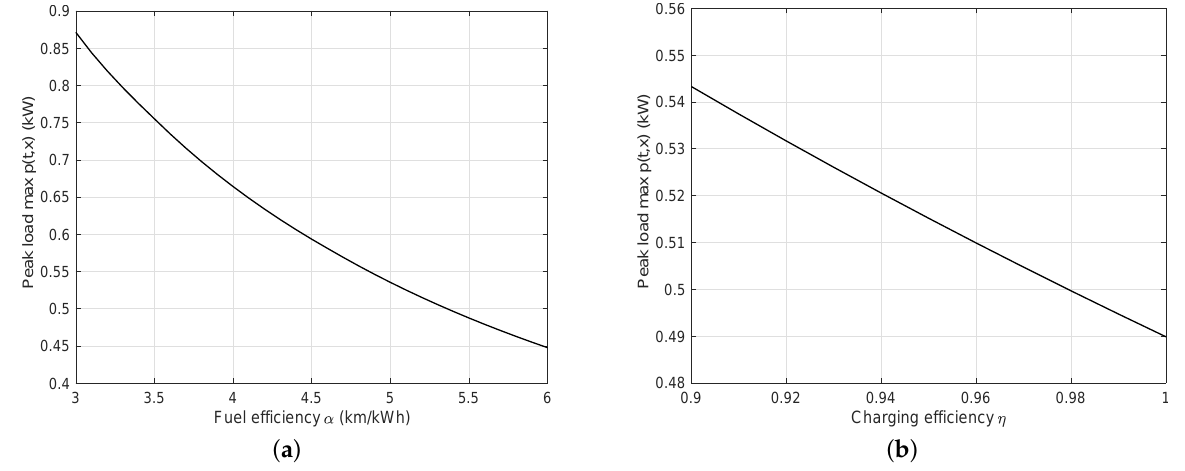
Figure 11. Peak loads from max t p ( t , x ) ( x = 39.6 km and ¯ ρ = 3 kW). ( a ) Peak load with respect to the fuel efficiency α for η = 0.95. ( b ) Peak load with respect to the charging efficiency η for α = 5.2 km/kWh.